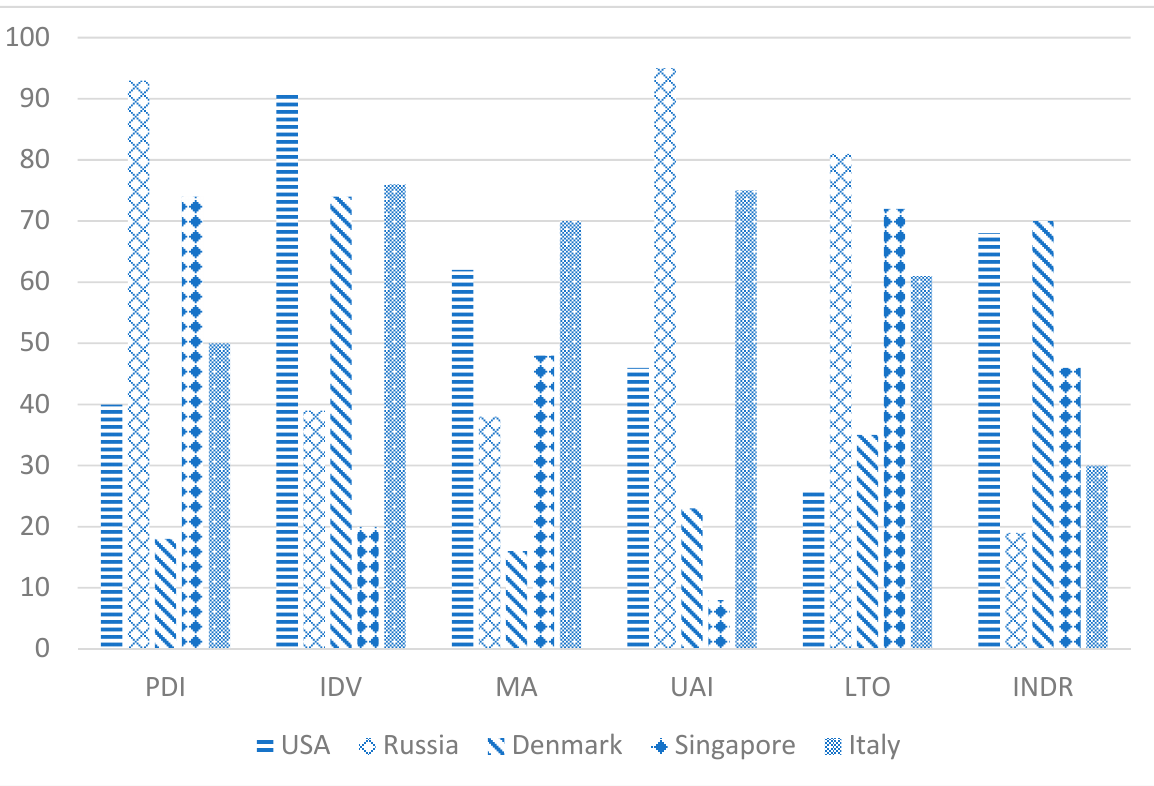
Figure 1. Examples of six dimensions of culture.